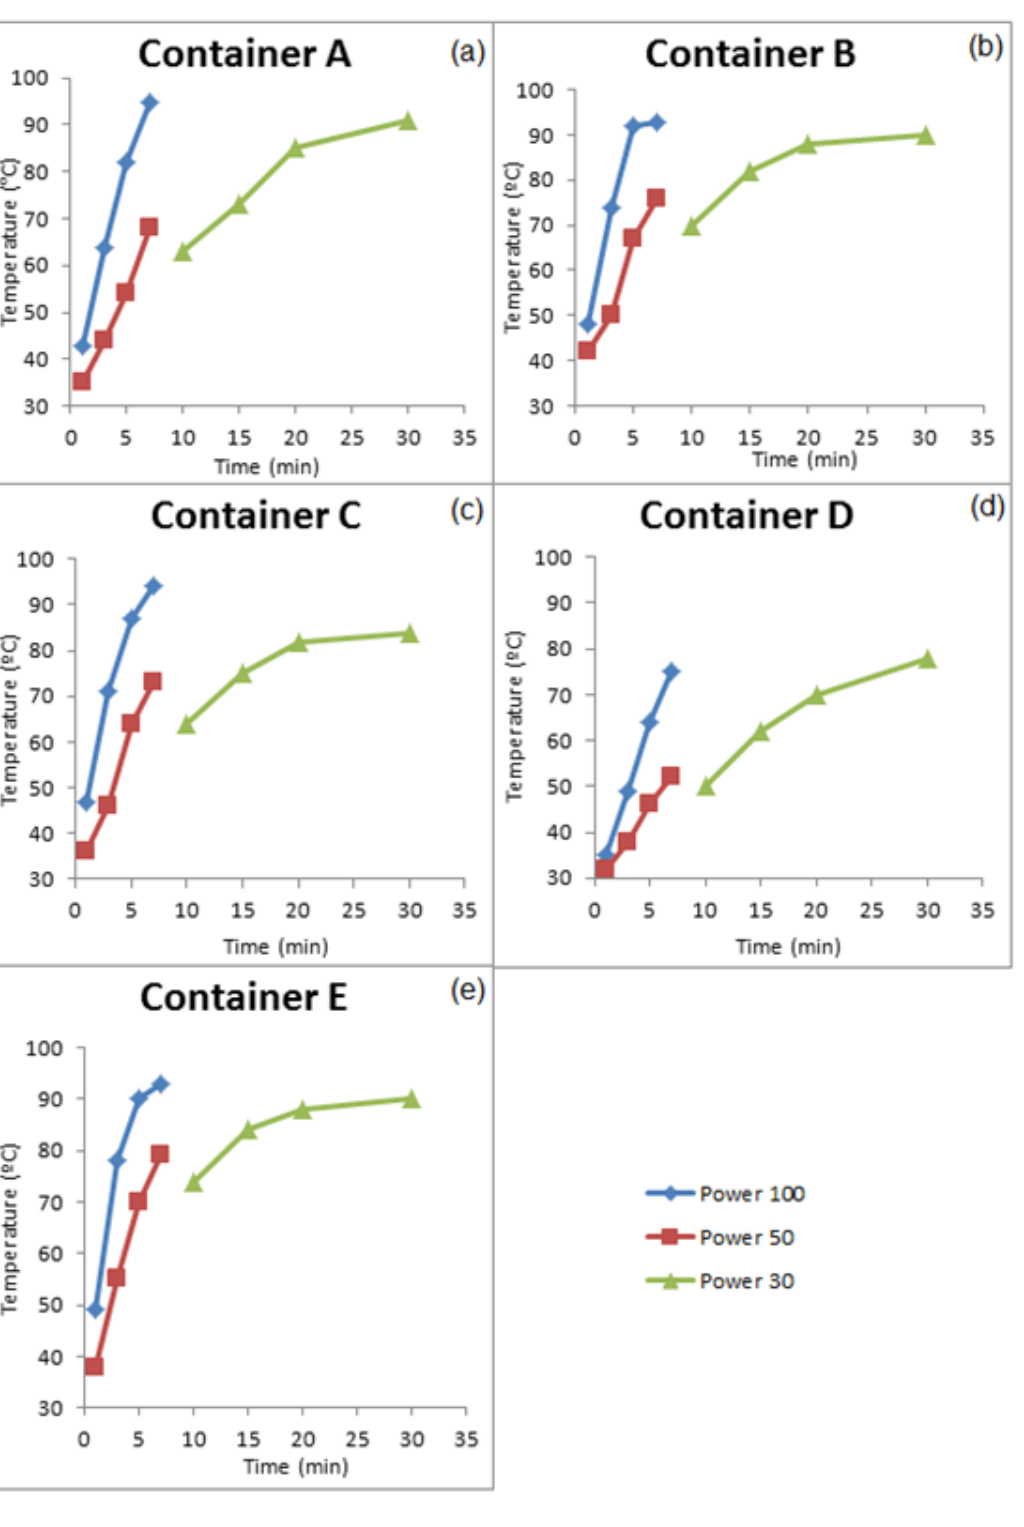
Figure 5. Temperatures of simulants measured for times and powers studied for Group I containers ( a ) Container A, ( b ) Container B, ( c ) Container C, ( d ) Container D, and ( e ) Container